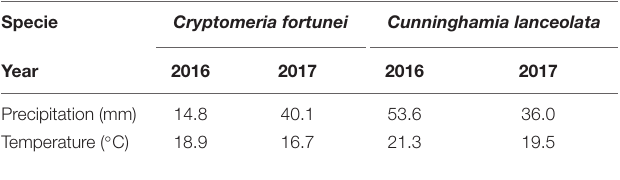
onset of xylogenesis in hot and moist regions remains